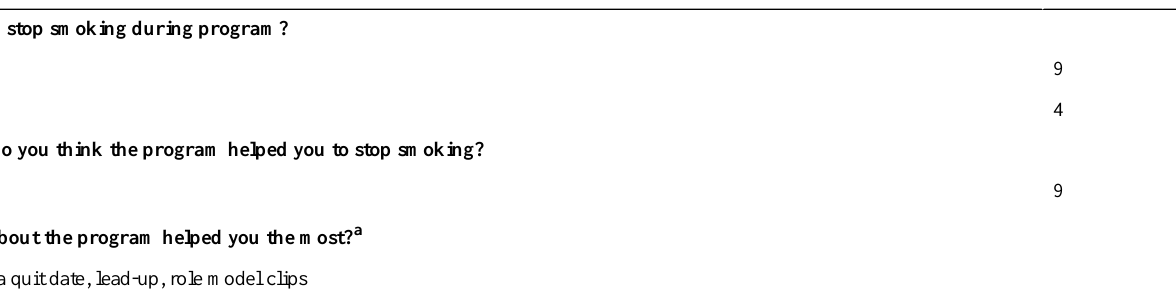
Table 5. Smoking outcomes (N = 13) Did you stop smoking during